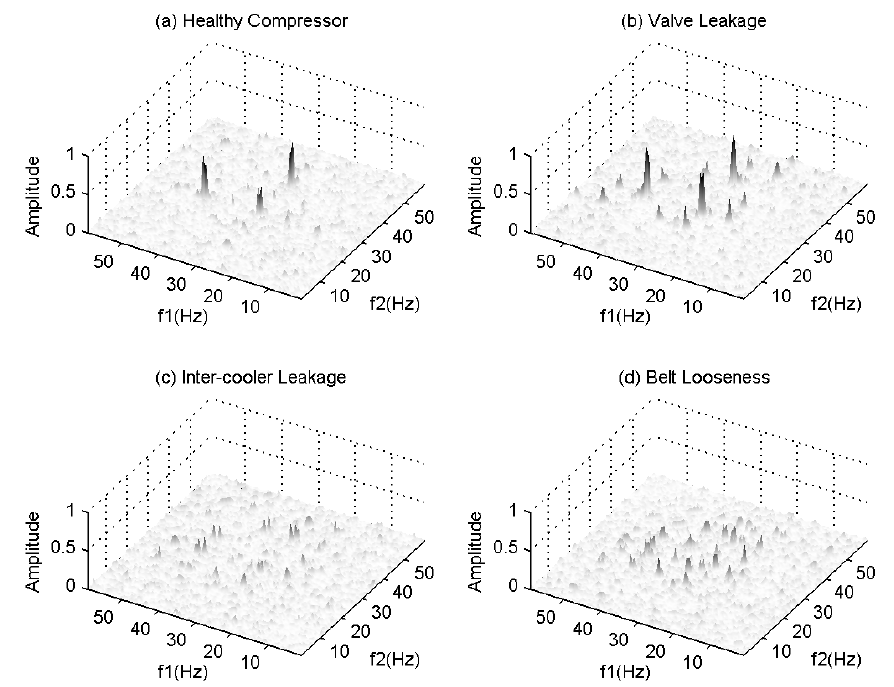
Figure 15. CB coherences for different conditions of the reciprocating compressor.